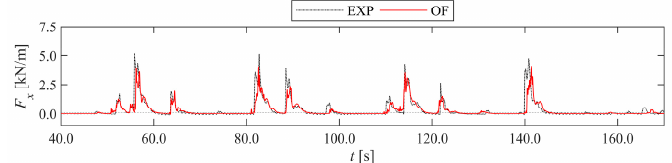
Figure 5. Comparison of U x time series at all sensor locations (for the PWs in ( a , c – e ); for the ECM in ( b )). The zero-reference is the promenade bottom at the sensor locations. For OF, both U x at the measured height above the promenade and the depth-averaged U x time series are shown.